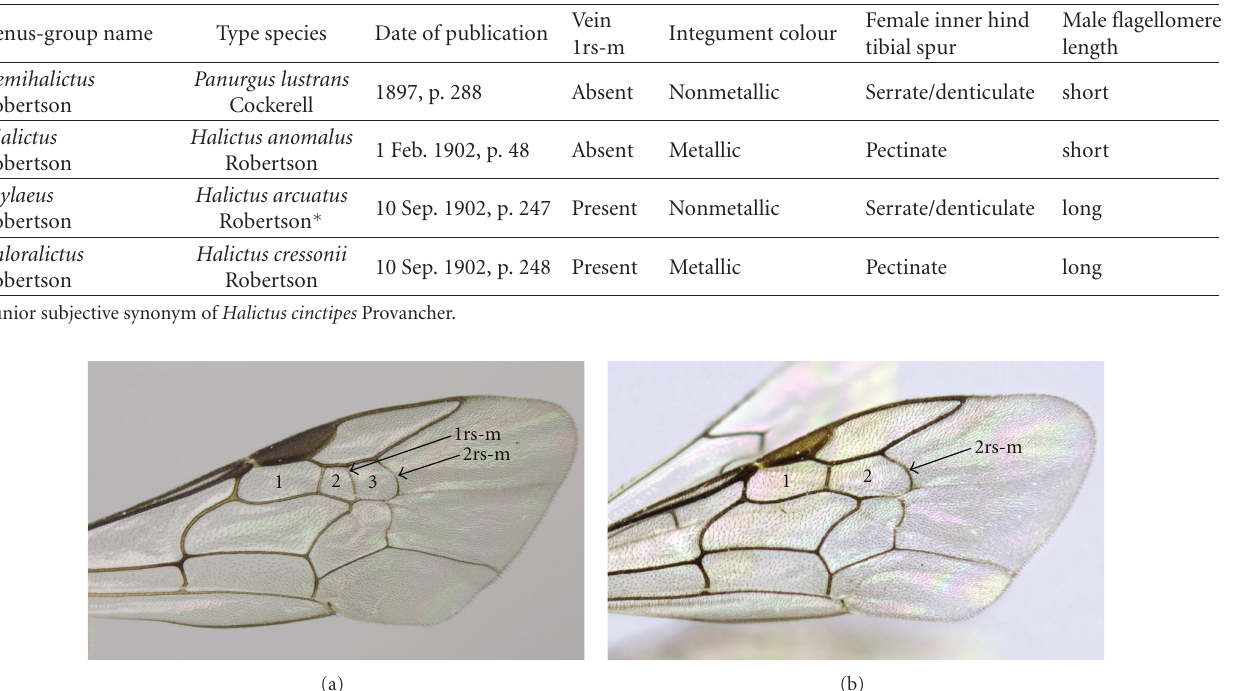
Table 1: Characteristics of Hemihalictus, Dialictus, Evylaeus, and Chloralictus type species.